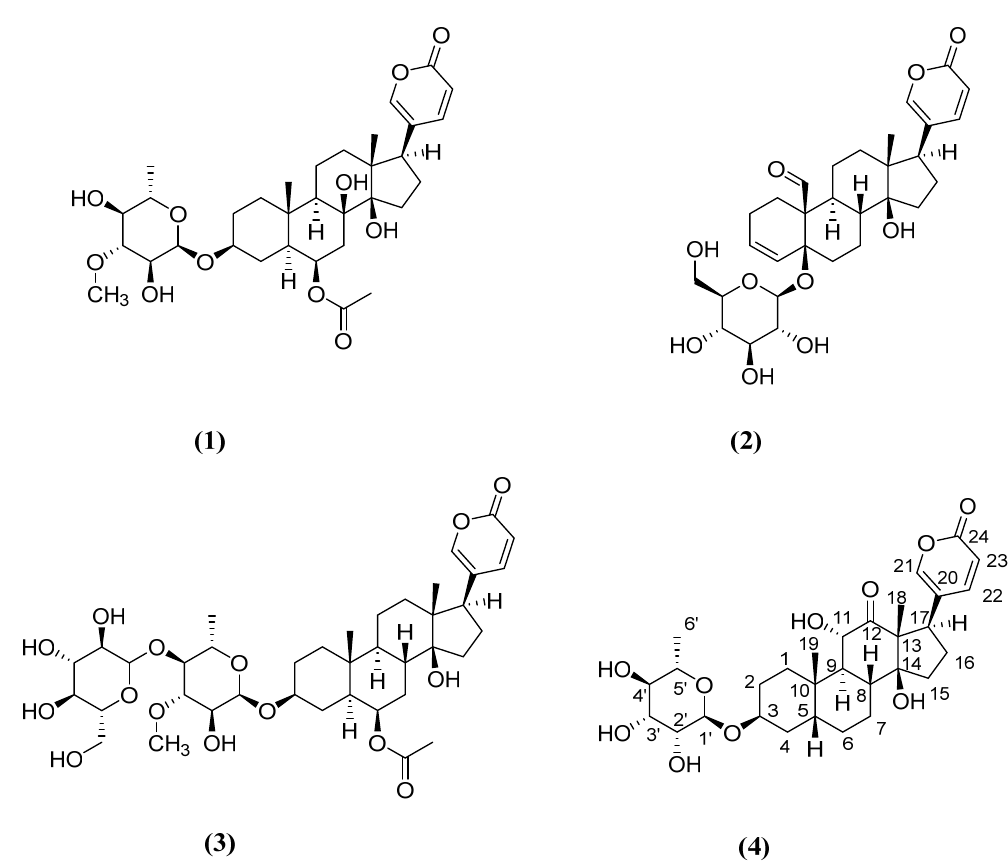
Figure 1. Chemical structures ( 1 – 4 ) of bufadienolides isolated from D. pancration